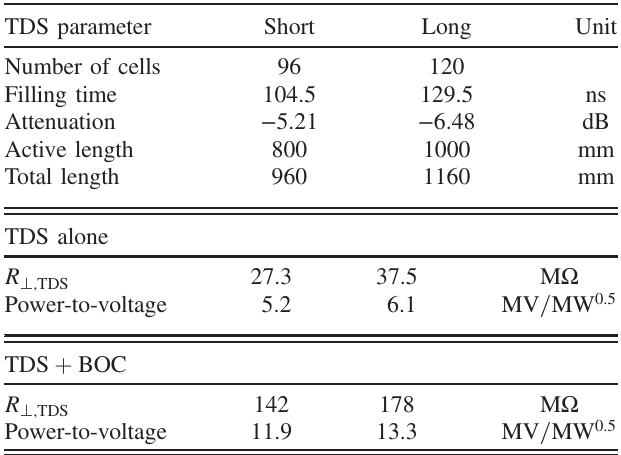
. t TABLE V. rf parameters for short and long X -band TDS. For operation of the TDS with BOC the following parameters